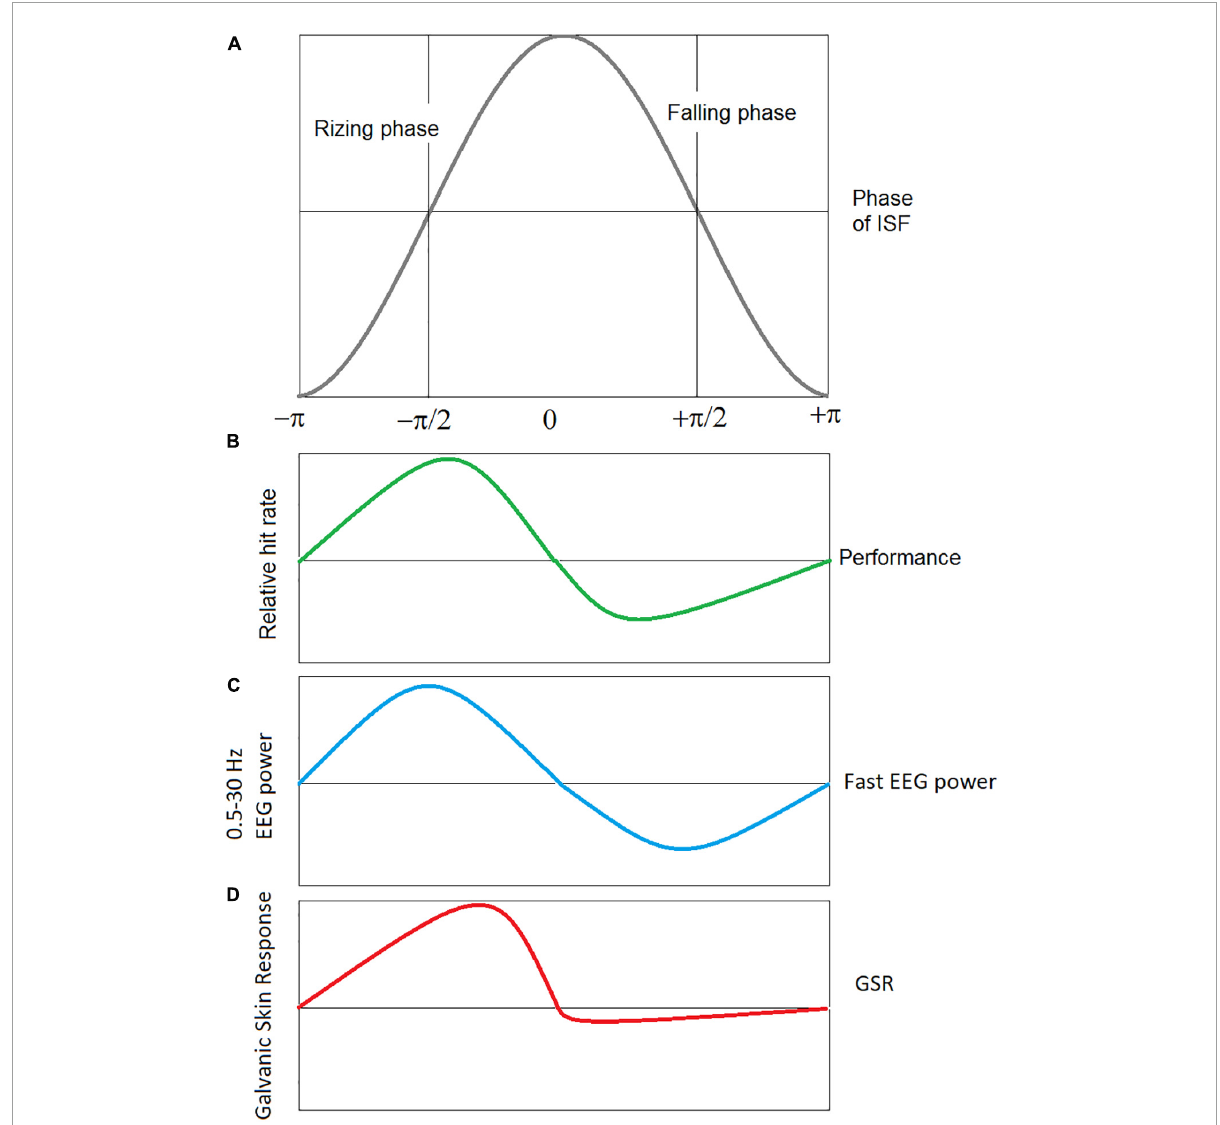
FIGURE4 Schematic presentation of correlation of the phases of EEG ISF with performance, power of conventional EEG bands, and GSR signals. (A) Infra-slow EEG oscillation with rising and falling phases. (B) Performance: hits and missies of near threshold electrical stimulation of the index finger were measured in healthy subjects while recording the full band EEG at Cz (Monto et al., 2008), (C) the EEG power in conventional EEG bands (from delta to gamma) is modulated with simultaneously measured ISF-EEG (Monto et al., 2008), (D) the EEG-ISF phase correlates with the galvanic skin response (GSR) amplitude, a measure of the arousal level (Sihn and Kim,